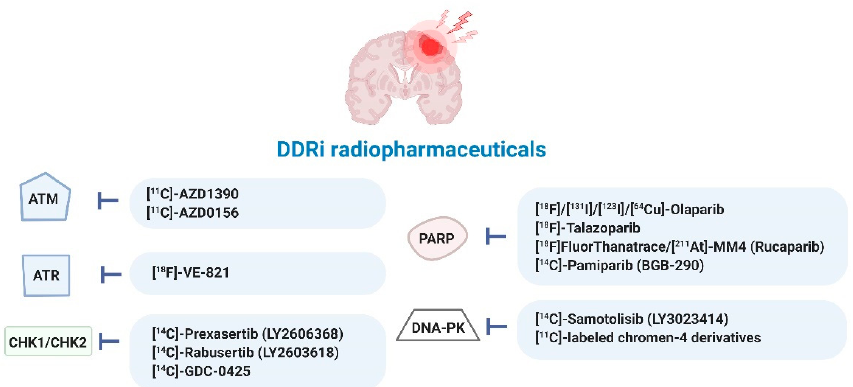
Figure 5. Radiopharmaceuticals targeting DDR kinases studied in various cancer types (for details see Table S2). Ataxia-telangiectasia mutated (ATM), ATM-RAD3-related protein (ATR), checkpoint kinase-1 and -2 (CHK1/2), DDR kinase inhibitor (DDRi), DNA-dependent protein kinase (DNA-PK), poly (ADP-ribose) polymerase-1 and -2 (PARP) [29,40,49,50,52–91] .